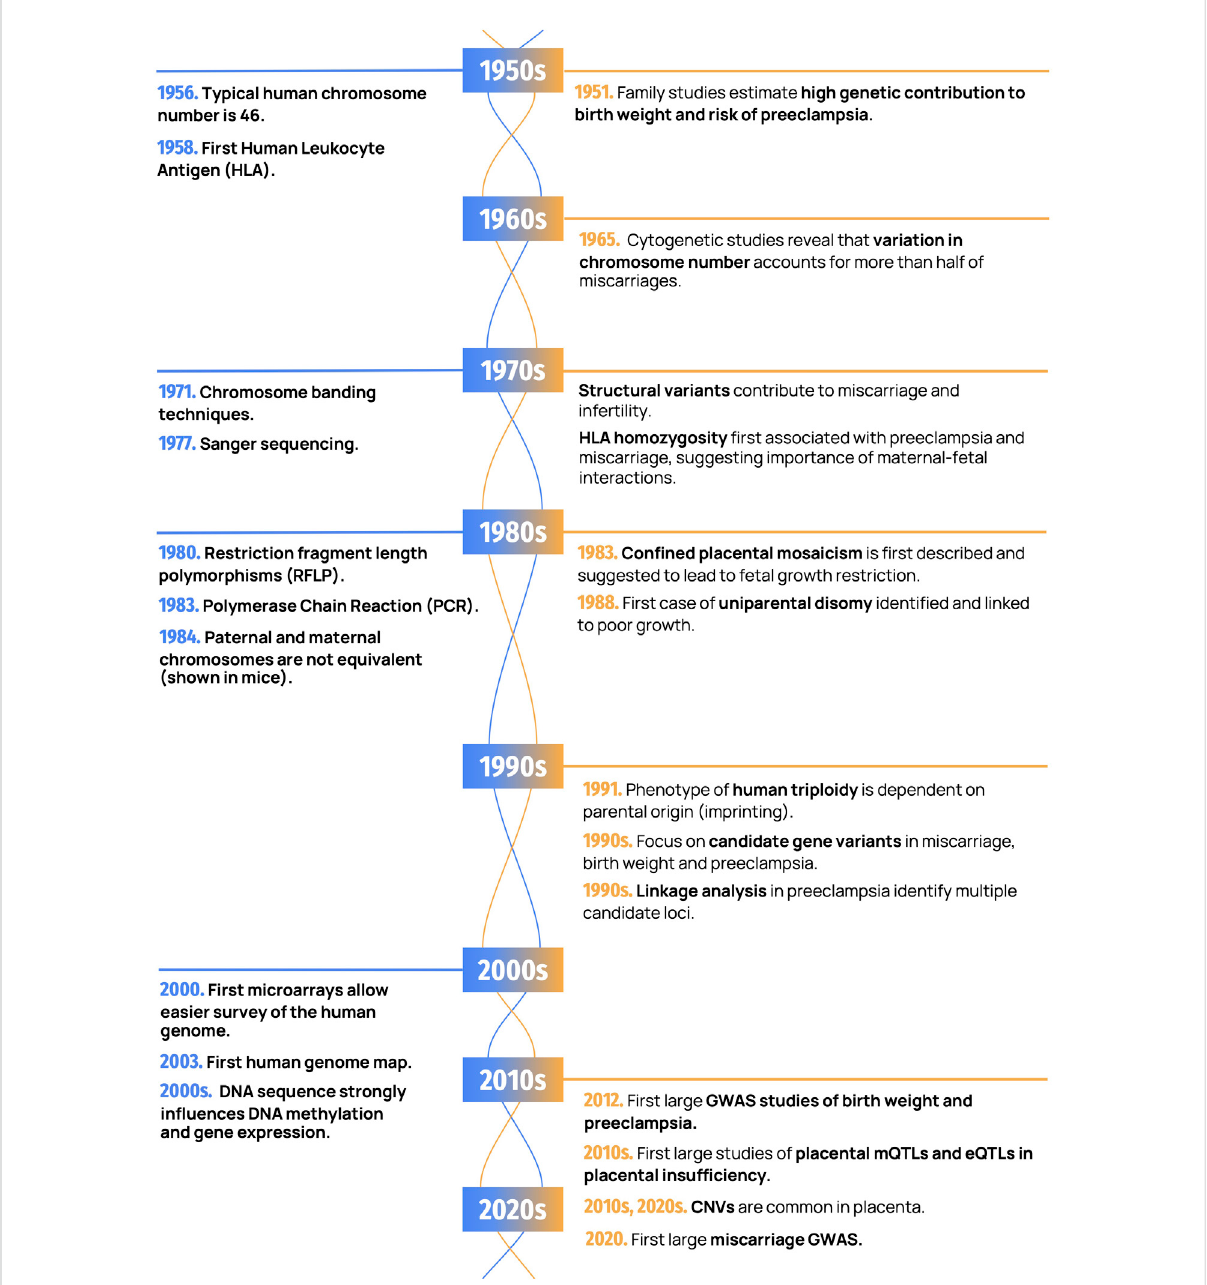
FIGURE 1 Important discoveries in human genetics and placental genetics. Landmark fi ndings in human genetics are shown in blue (on the left) and placental genetics in orange (on the right).